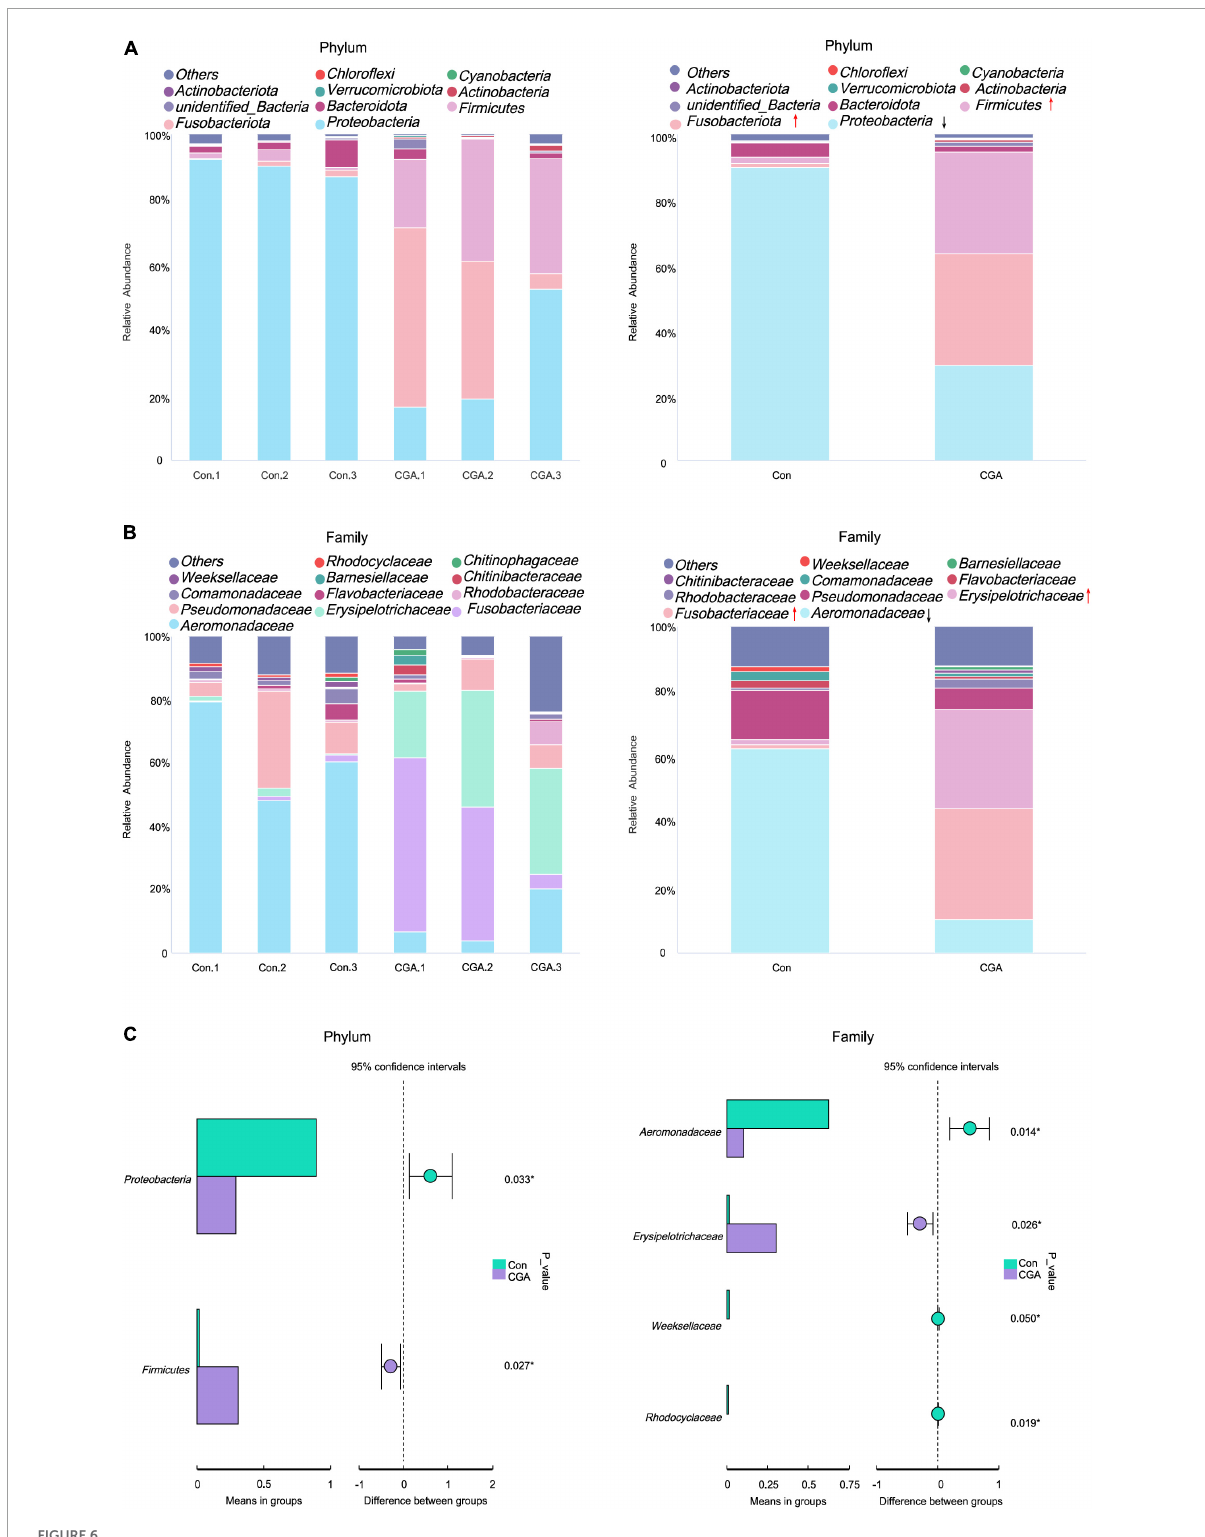
FIGURE6 Bar chart of relative abundance of intestinal species. (A) Histogram of phyla level relative species abundance. (B) Histogram of relative abundance of species at the family level. (C) The changes of the main species between the two groups. con.1, con.2, and con.3 are the control group (Con), and chlorogenic acid (CGA).1, CGA.2, and CGA.3 are the CGA-added group (CGA). The green box represented Con; the purple box represents CGA. *Indicates a significant difference compared to the control group ( P <